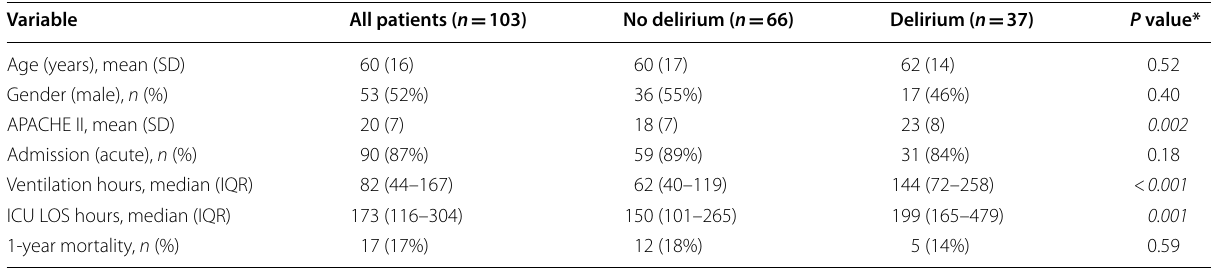
Table 1 Demographic and clinical characteristics of all patients, and of patients with and without delirium during